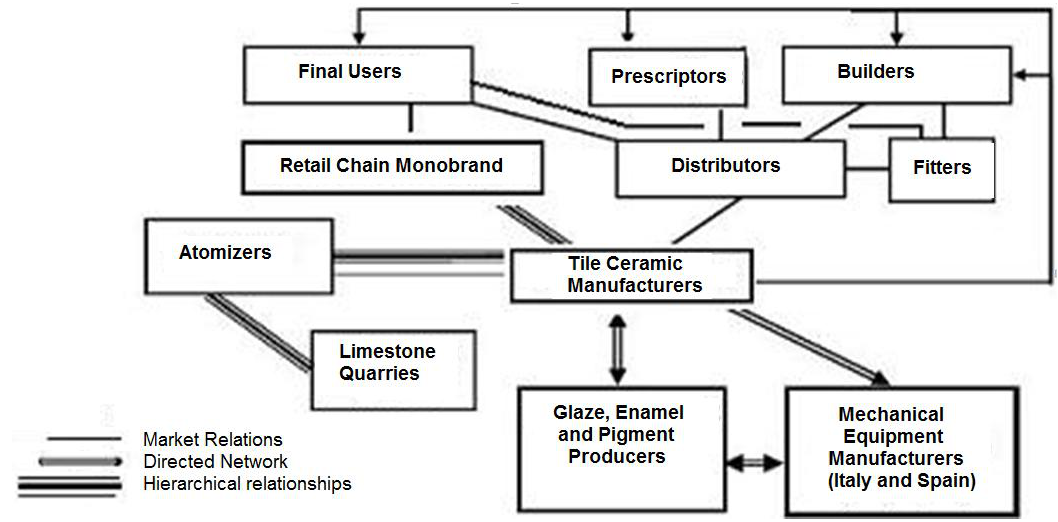
Figure 2. Governance relationships among the actors of the ceramic tile